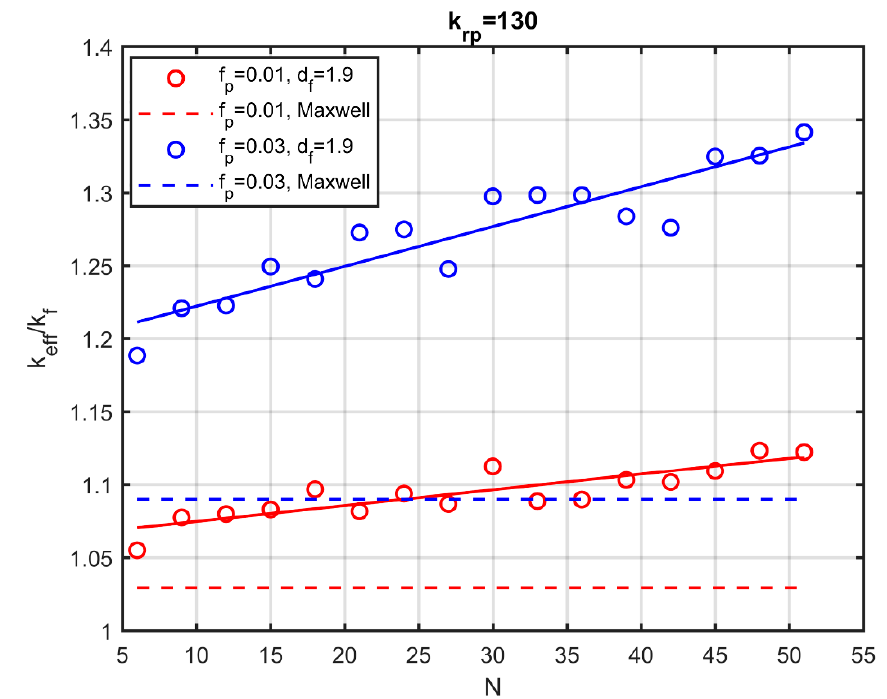
Figure 10. Effective thermal conductivity as a function of the number of particles in the aggregate. Blue lines: f p = 0.03, Red lines: f p = 0.01 Dashed lines: Maxwell’s model.